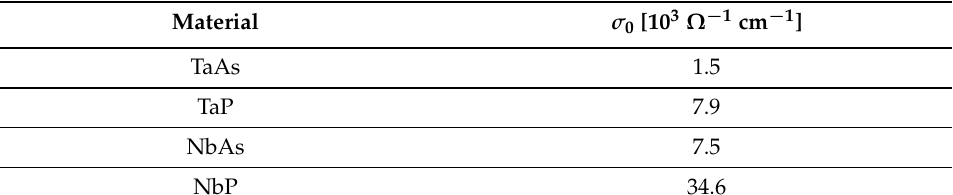
Table 4. Computed values for the total conductivity σ 0 = σ ( T = 0 ) at zero temperature for each material. We consider a value of n d = 10 11 cm − 2 .